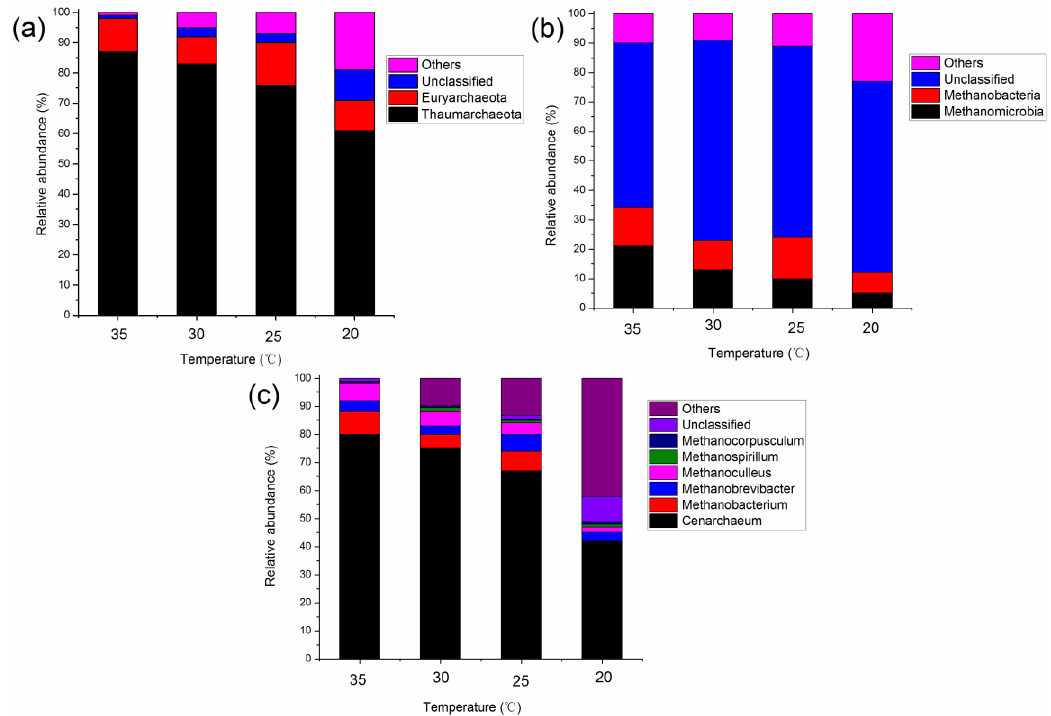
Figure 5. Microbial community structure in the methanogenic phase at different temperatures: ( a ) phylum level; ( b ) class level; ( c ) genus level.